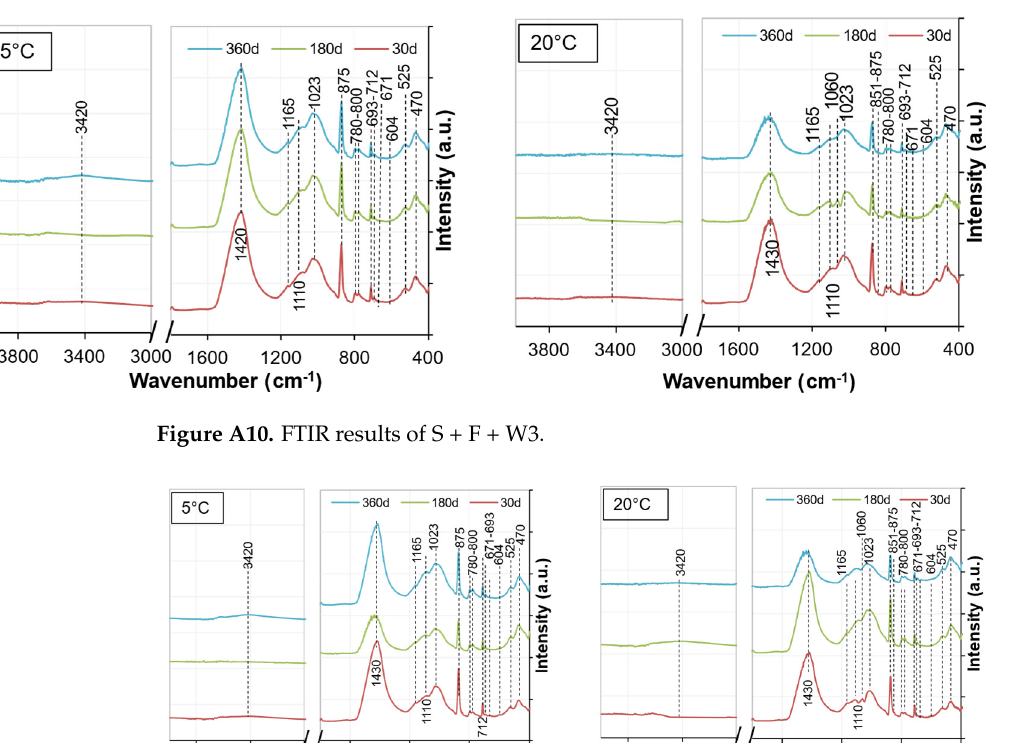
Figure A9. FTIR results of S + F + W1.